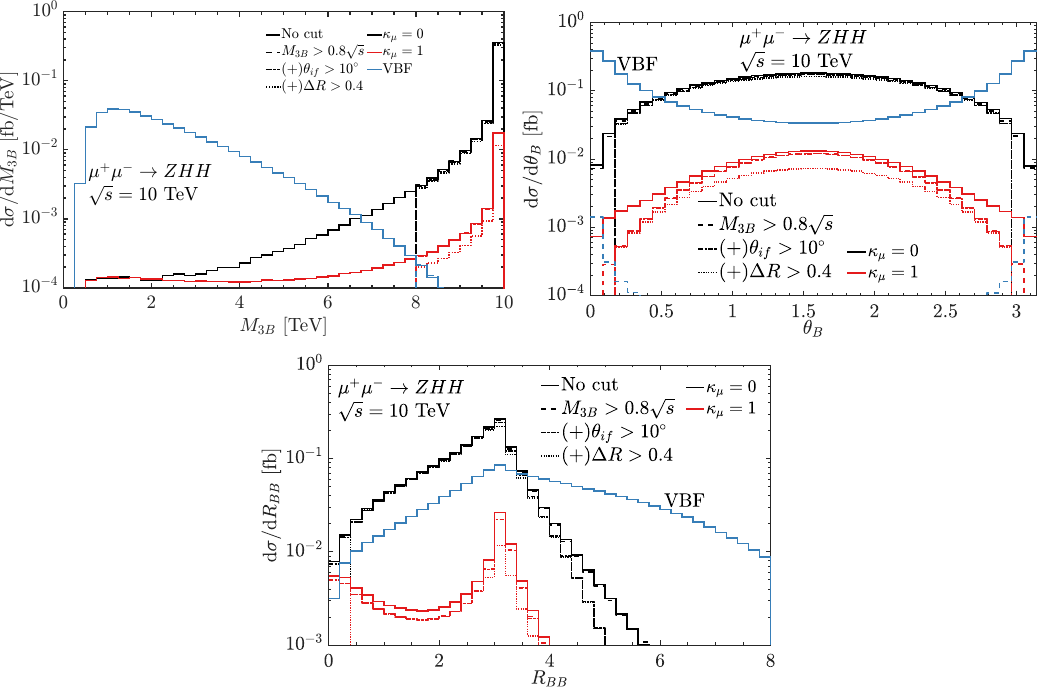
Figure 10 . The kinematic distributions for θ B , R BB , and M 3 B as in figure 9, but for ZHH √ production at a s = 10 TeV µ + µ −